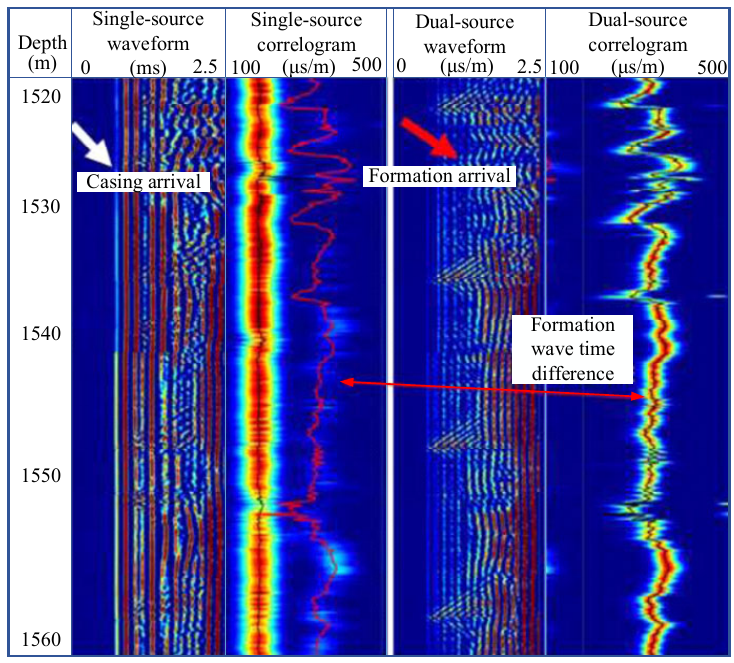
Figure 9. Processing results of the logging data collected by the designed tool in the depth section of 1520 m~1560 m. From left to right, the panels in the figure are the depth, the variable density log (VDL) display of the far transmitter, the Slowness–Time–Coherence (STC) correlogram of the far transmitter, the VDL display of the dual ‐ source, and the STC correlogram of the dual source. It is worth mentioning that the casing wave in the actual dual ‐ transmitter measure ‐ ment may not be completely canceled. The above experiments show that about 90% of the casing wave amplitudes are canceled, which means that casing waves will still exist in the data of a dual ‐ transmitter tool. Compared with the single ‐ source excitation logging data processing results, the casing wave is mostly suppressed with the dual ‐ source method. The formation signal is visible, indicating that the signal ‐ to ‐ noise ratio has been greatly improved. The STC correlogram shows that the P ‐ wave slowness varies with depth. As a result, the correlation of formation compressional waves is significantly improved. The slowness of formation compressional waves can be easily extracted, and the extracted for ‐ mation P ‐ wave slowness curve is displayed in the third panel of the STC correlogram of the far transmitter. It certifies that the extracted slowness curve coincides with the (weak) formation P ‐ wave correlation signal. By suppressing the amplitude of the casing waves, the dual ‐ source tool can now achieve adequate sampling for the formation acoustic signal in the A/D digitization processing; meanwhile, the signal ‐ to ‐ noise ratios of the collected data are significantly enhanced. On the other side, the remaining casing waves can now be suppressed by signal processing methods easily. 6. Conclusions To realize acoustic through ‐ casing logging, an acoustic tool with dual ‐ source trans ‐ mitters was developed, in which an additional transducer was added to suppress casing waves. The structure of the tool was basically the same as that of the conventional logging tool. The span distance between the two transmitting transducers was designed to be 0.15 m, and the spacing distance between the transmitting transducer and the receiving trans ‐ ducers is 2.59 m. A dual ‐ source transmitting circuit was designed to carry out two excita ‐ tion signals of opposite polarity, good consistency, and high emission power. The tool was tested in cased exploration wells; the experiment endings showed that about 90% of the casing wave amplitudes were canceled. The casing waves cannot be fully canceled. First,